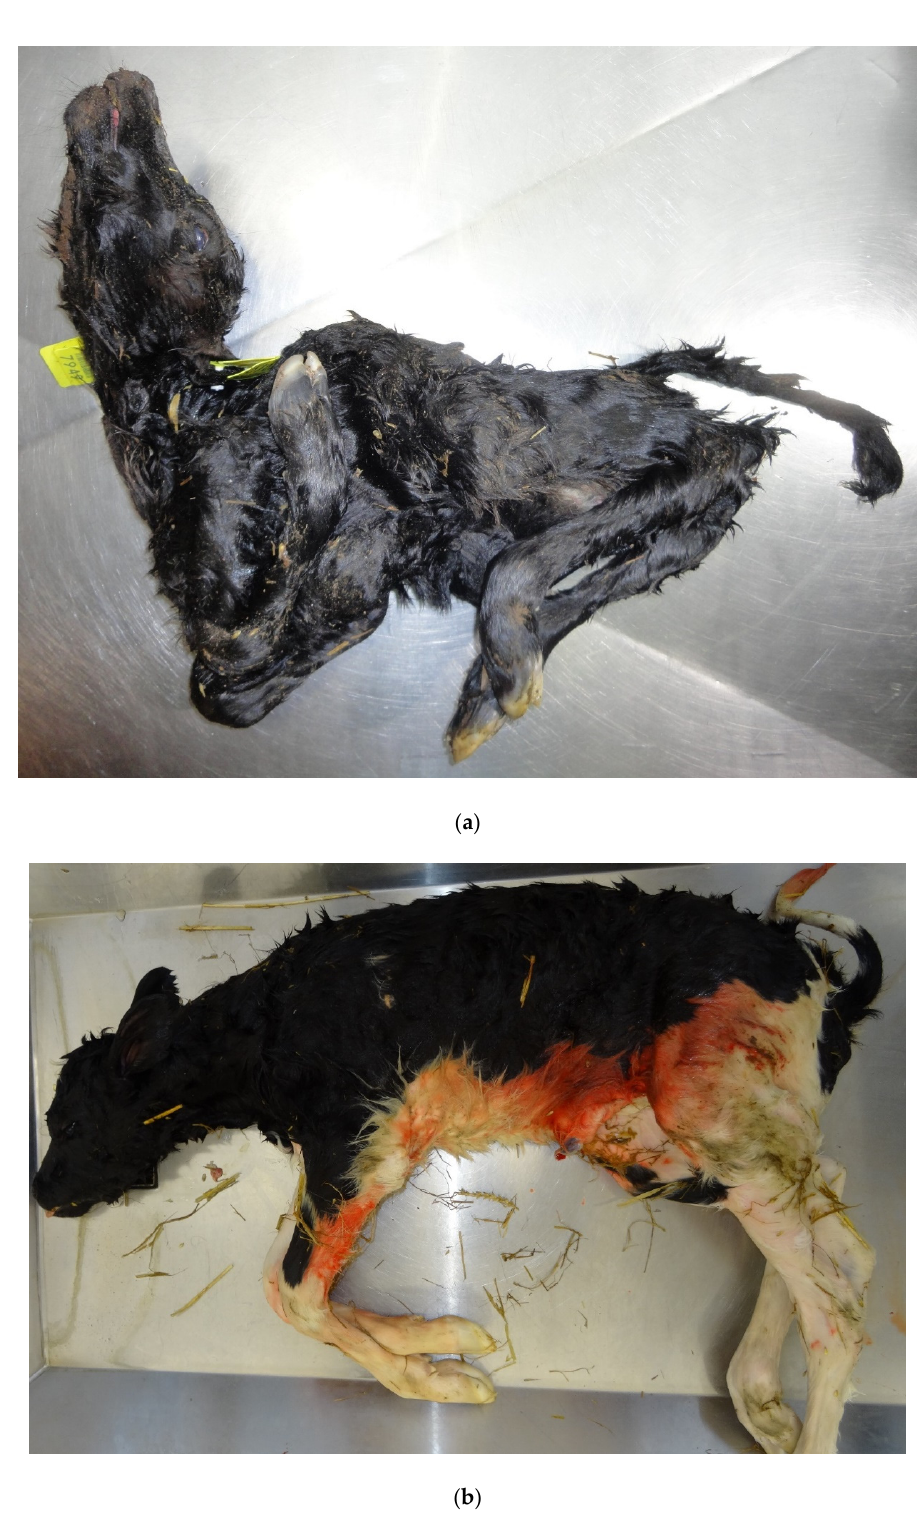
Figure 4. ( a ). Typical lesions of Schmallenberg infection (arthrogryposis, torticollis, kyphosis) in a bovine foetus PCR-positive for the virus. ( b ). Fetus exposed to Schmallenberg virus in utero and antibody–positive, but without the pathognomonic lesions.